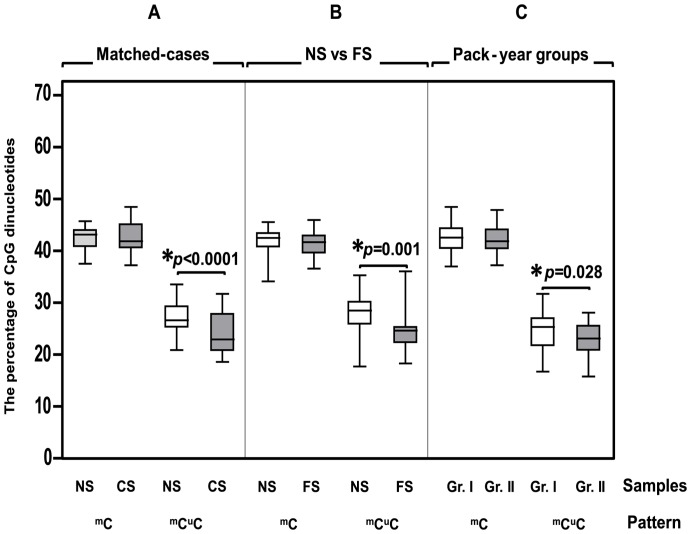
%mCuC in the matched cases, FS, and pack-year groups.
mCuC represented %mCuC. The percentage of overall LINE-1 methylation level was depicted as mC. (A) To account for potential confounding factors, we matched the NS to the CS based on age, gender and alcohol drinking. The CS showed a significantly lower %mCuC. (B) The FS also had a significantly lower %mCuC. (C) %mCuC was significantly lower in the higher pack-year smoking (group II) than in lower pack-year group (group I).